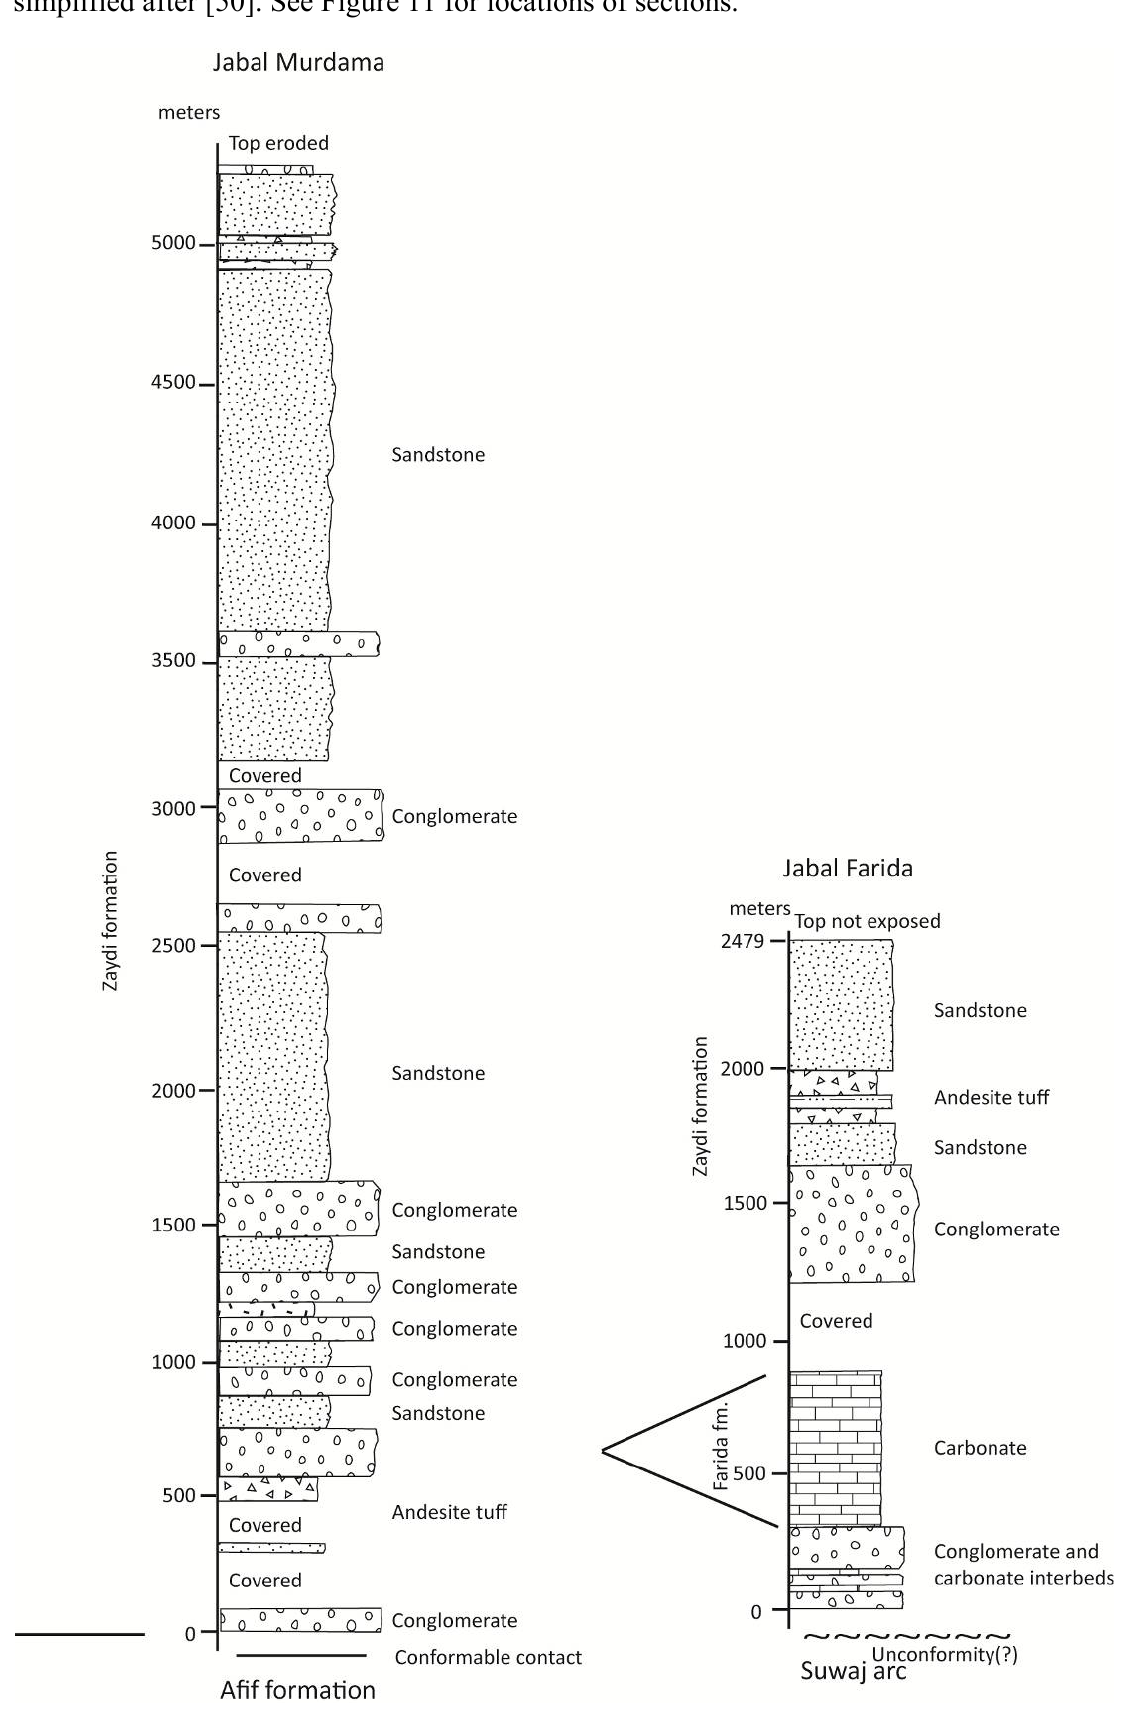
Figure 13. Stratigraphic columns of two sections in the lower part of the Murdama group, simplified after [50]. See Figure 11 for locations of